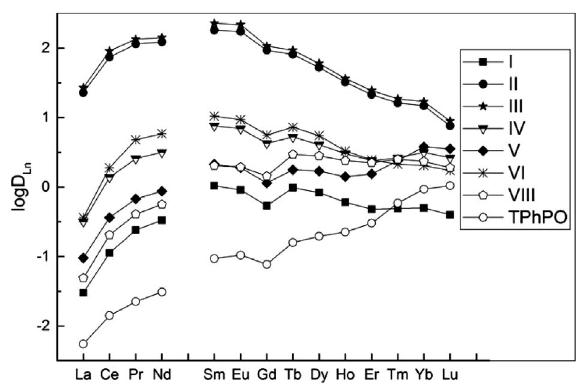
Figure 1. The extraction of lanthanides(III) with HP–compounds I – VIII and TPhPO mixtures in 1,2-dichloroethane at [HP] = 0.02 M, [L] = 0.005 M and pH = 2.0. Figure 2. The extraction of lanthanides(III) with HP–compound III